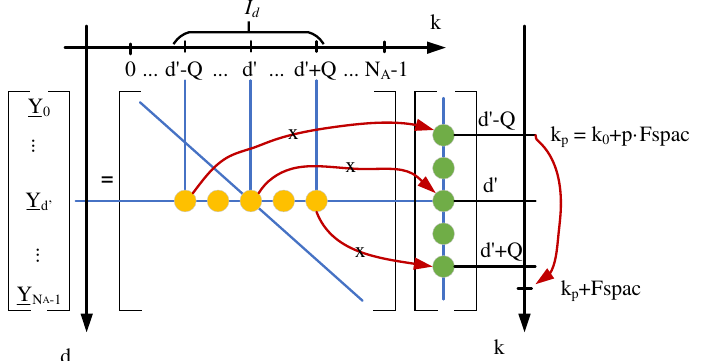
Figure 5. Sketch of proof for Remark 1: minimum spacing between pilot tones to avoid Inter-Carrier Interference